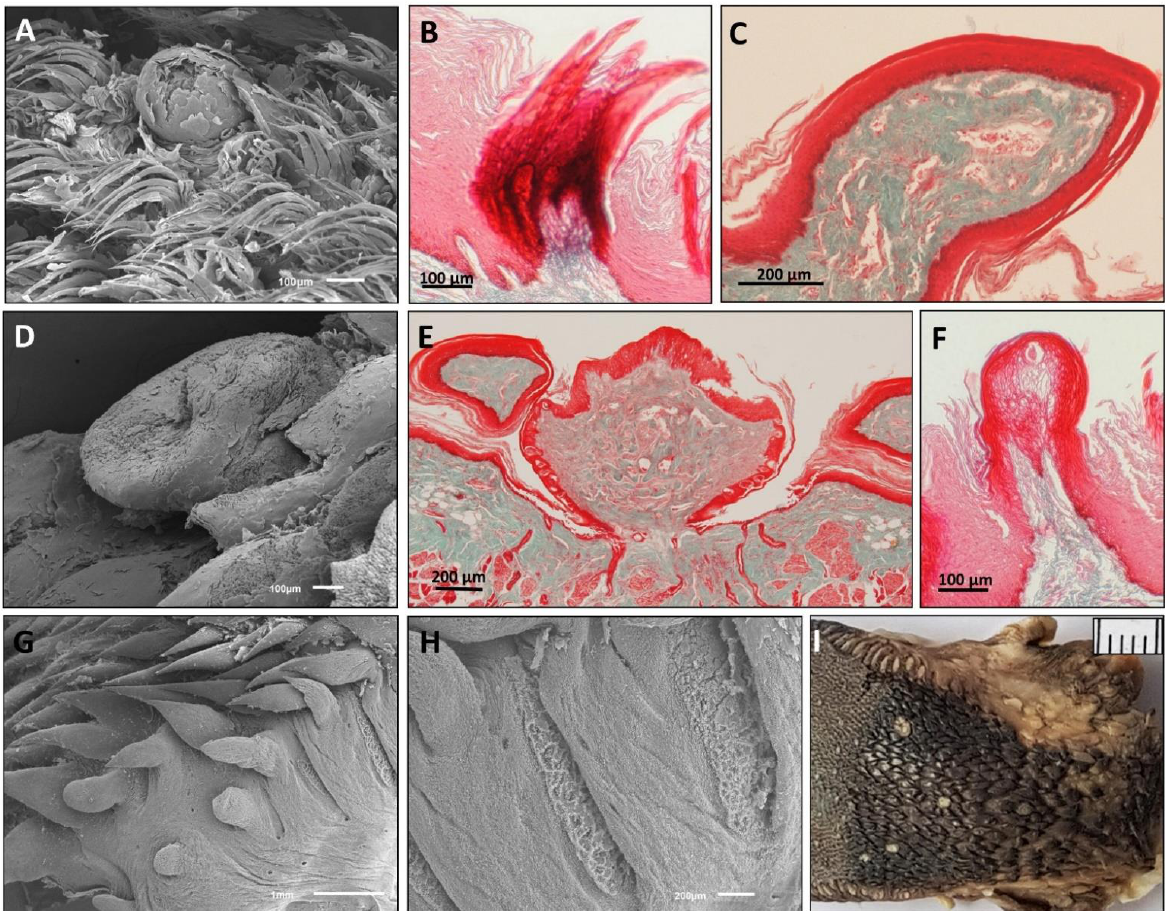
Figure 6. All images correspond to Lemur catta papillae. SEM images can be observed of fungiform and filiform ( A ), circumvallate and conical ( D ), and foliate and conical ( G , H ). Also presented are Masson trichrome-stained images of filiform ( B ), conical ( C ), circumvallate surrounded by conical ( E ) and a fungiform papilla displaying a taste bud at the top ( F ). Image ( I ) clearly shows the Y-shaped organization of circumvallate papillae. A width of one millimeter has the minor division in image ( I